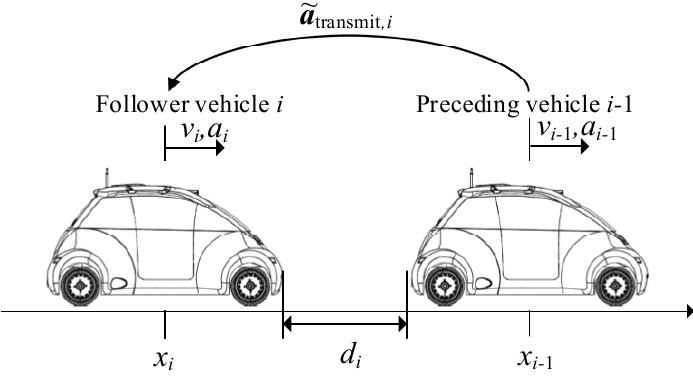
Figure 1. Platooning linear model with information flow [26].